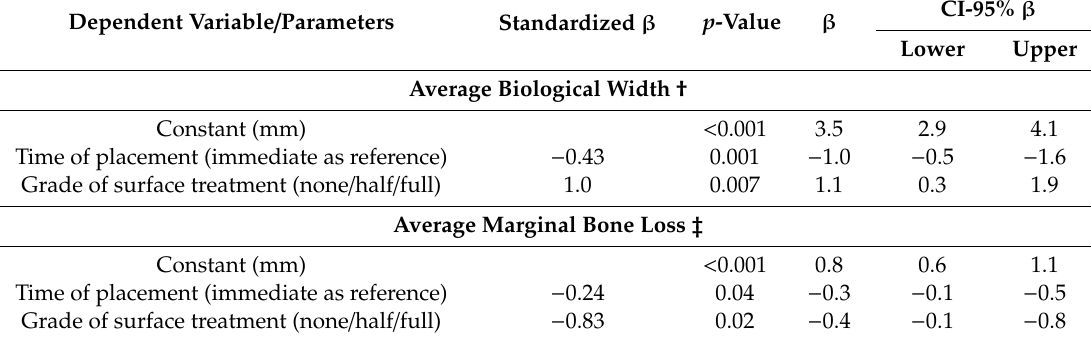
Table 7. Linear regression model (backward stepwise) for predicting the average biological width and the average marginal bone loss after including all the potential predictors (time of implant placement and grade of surface treatment). * For these analyses, the mechanized implants placed on the M 1 were excluded to assess the true e ff ect of the platform configuration. † F = 6.97: df:2; p -value = 0.001. R 2